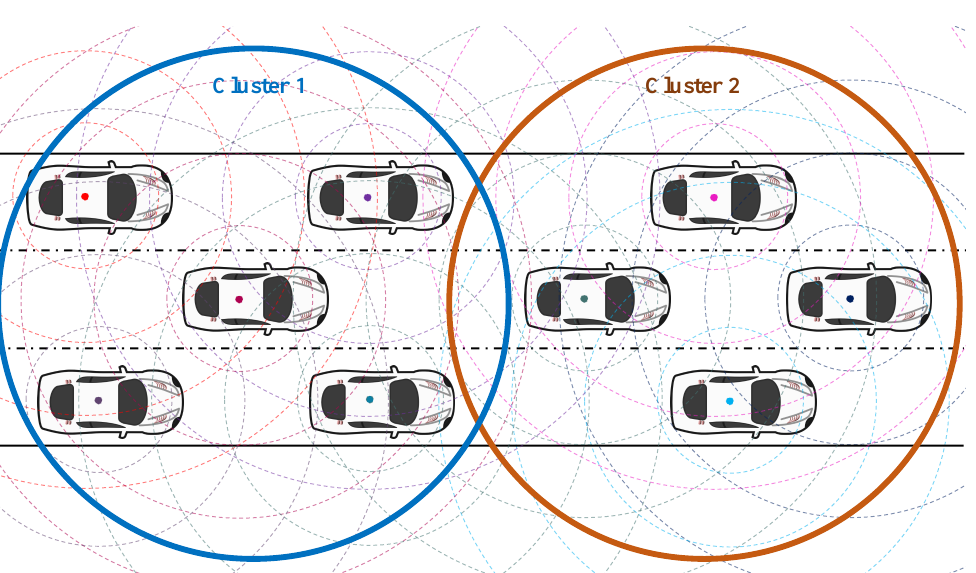
Figure 3. The proposed K-means clustering method for vehicle clustering in push-based data forwarding in VNDN.